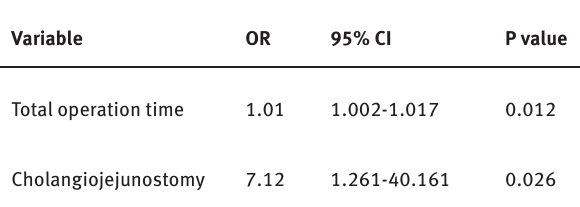
Table 2: Multivariate analysis for the risk factors of bile leakage